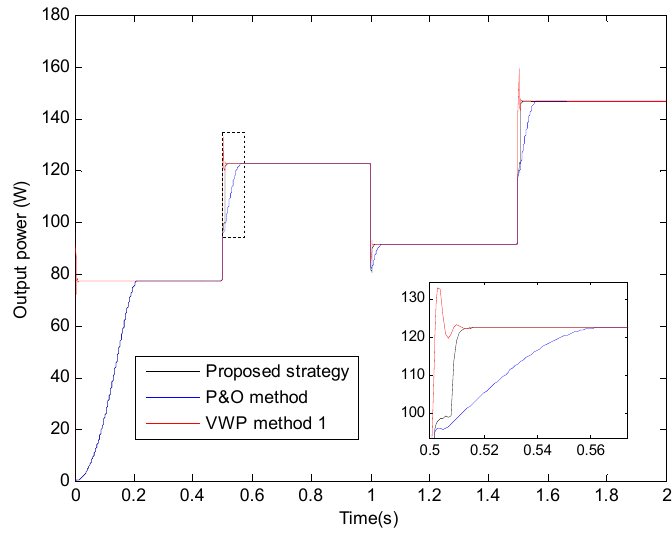
Figure 35. Compared power curves of the different methods. Table 10. Simulation parameters and results corresponding to Figures 33–35.